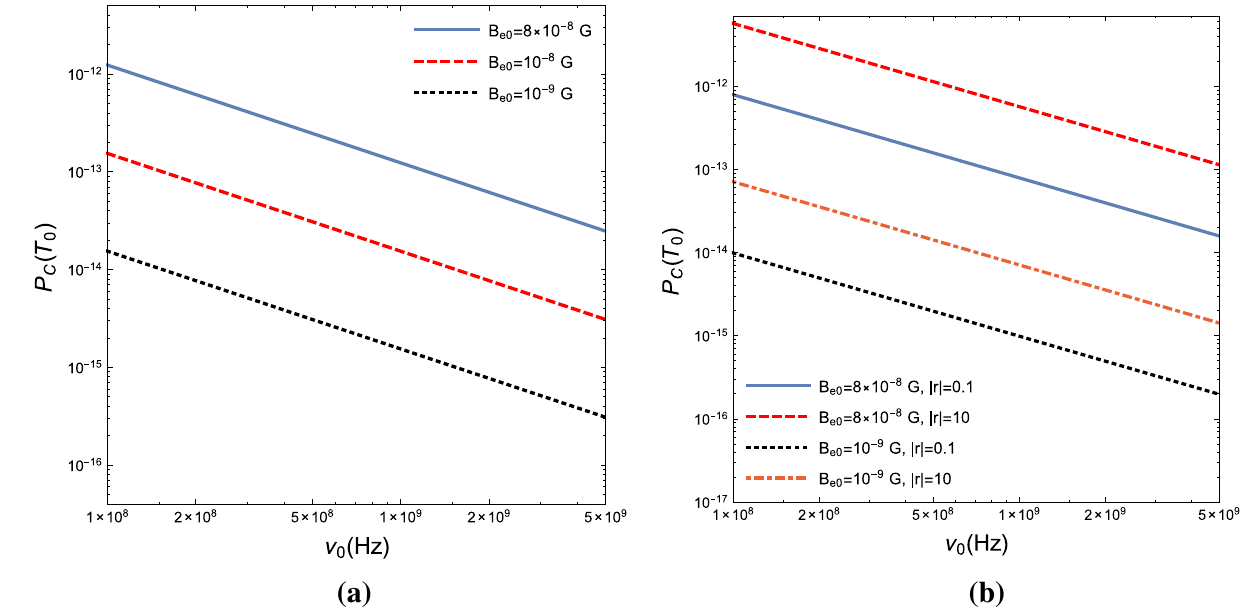
Hz for magnetic field amplitudes B e 0 = 8 × 10 − 8 G (continuous line), B e 0 = 10 − 8 G (dashed line), B e 0 = 10 − 9 G (dotted line) are shown. In all plots in b we used a value of | Q i | = 10 − 6 , | r | = 1 and values of (cid:16) = π/ 4 and (cid:17) = π/ 3. In a the values of the parameters have been chosen in such a way that condition (65) is